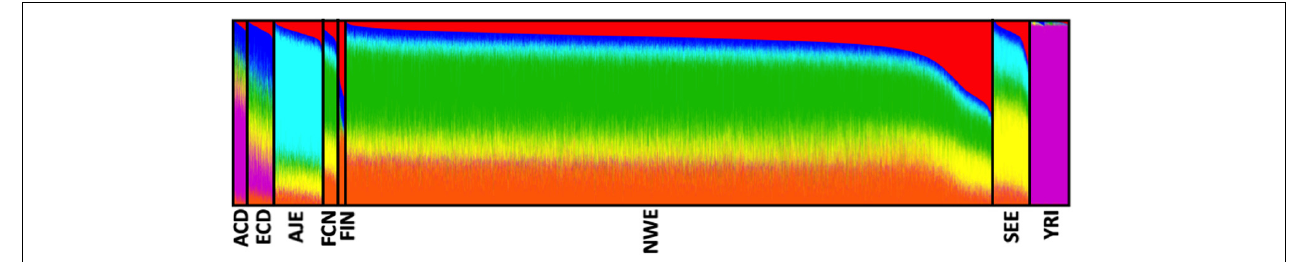
FIGURE 2 | Analysis of the genetic structure confirmed the effectiveness of our ancestry-determination pipeline. Ancestry proportions of the 21,492 unrelated subjects studied (from the eight determined ethnic groups) as revealed by the ADMIXTURE software (Alexander et al., 2009), using pruned (MAF ≥ 0.01, r 2 ≤ 0.1) SNPs at K = 6. Each color represents a different ancestral component, and each ancestry is a mixture of different components. ACD, African–Caribbean from Dominican Republic; AJE, Ashkenazi-Jewish Europeans; ECD, European–Caribbean from Dominican Republic; FCN, French–Canadians; FIN, Finnish Europeans; NWE, North-Western Europeans; SEE, South-Eastern Europeans; YRI, African Yoruba.